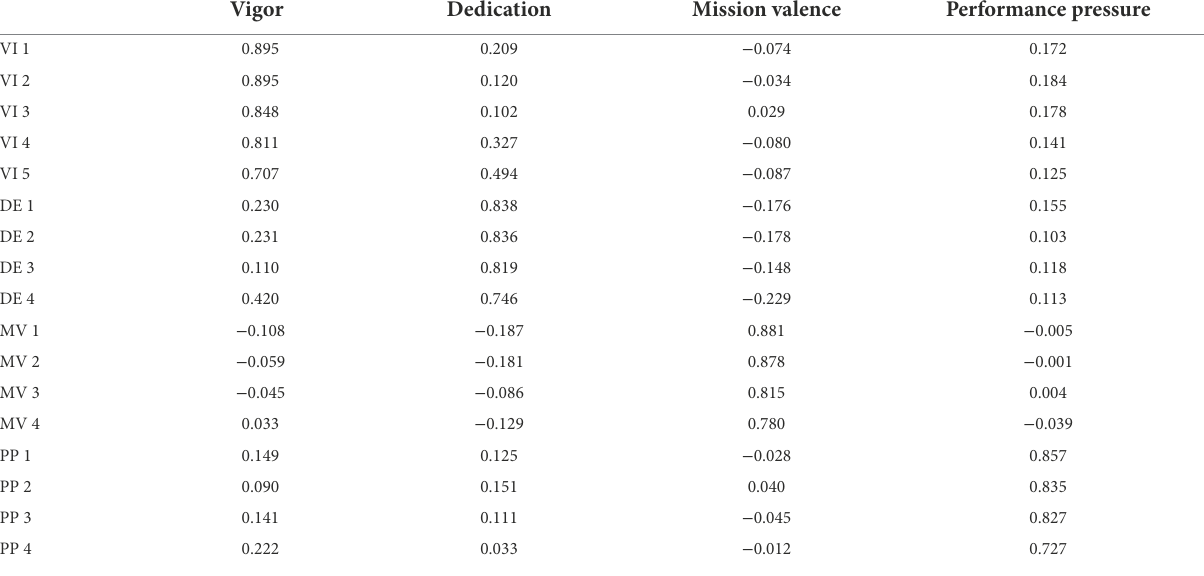
TABLE 3 Exploratory factor analysis (EFA)